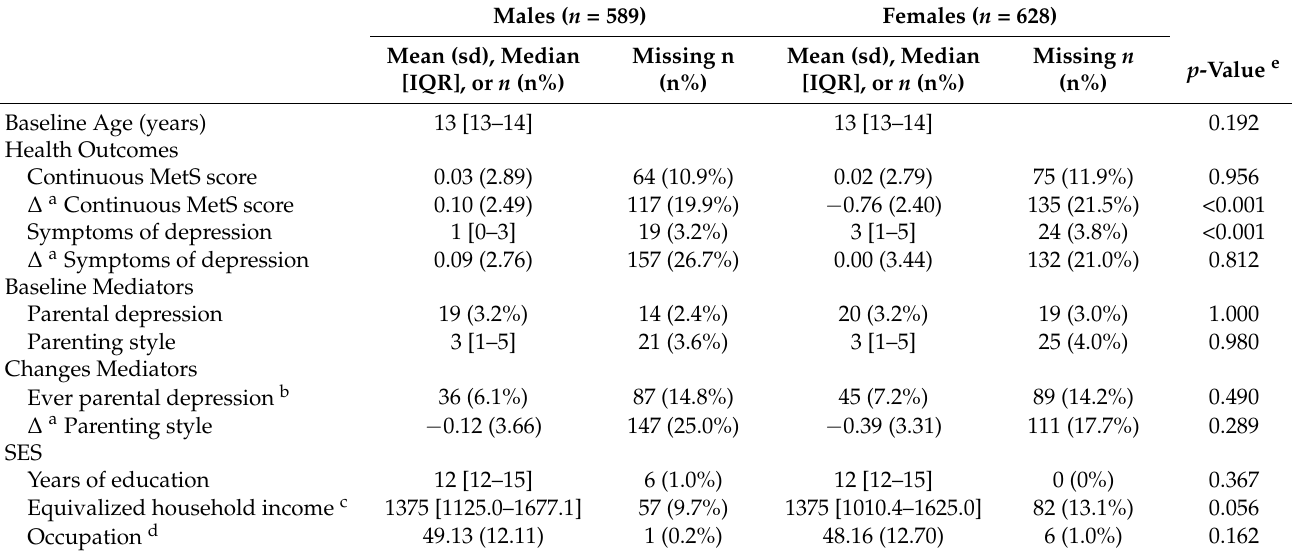
Table 1. Description of the characteristics of the study population used in the analyses ( n = 1217), stratified by sex. The number of participants and percentages are shown for categorical variables, means and standard deviations are given for normally distributed continuous variables, and the median and interquartile range are provided for non-normally distributed continuous